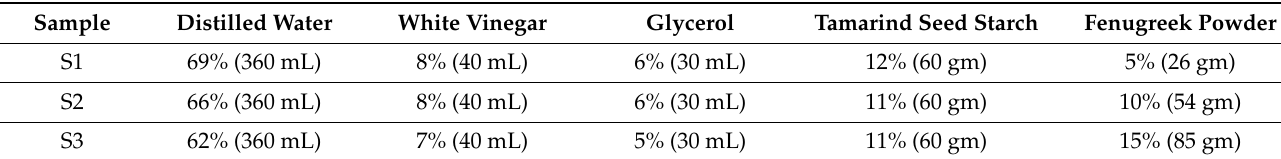
Table 3. The used constituents with their percentages.